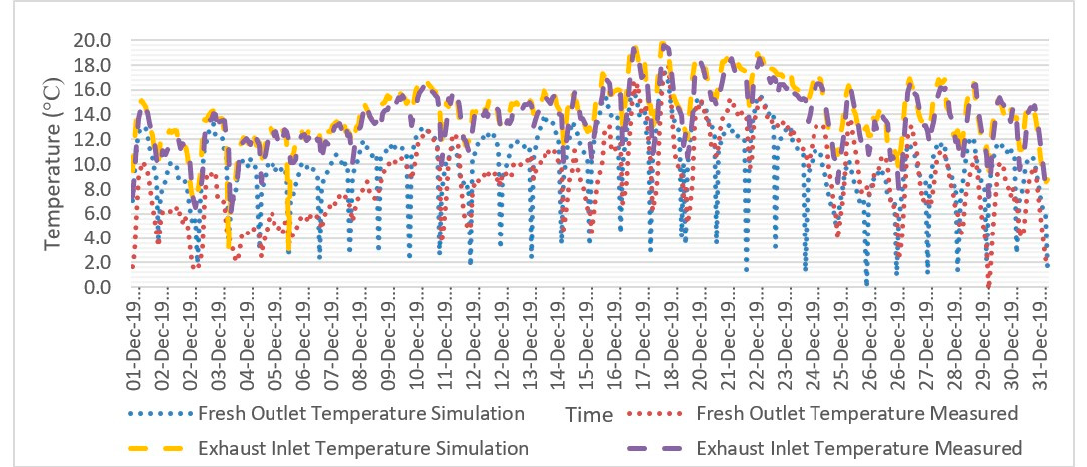
Figure 6. The fresh outlet and exhaust inlet around the heat during winter.